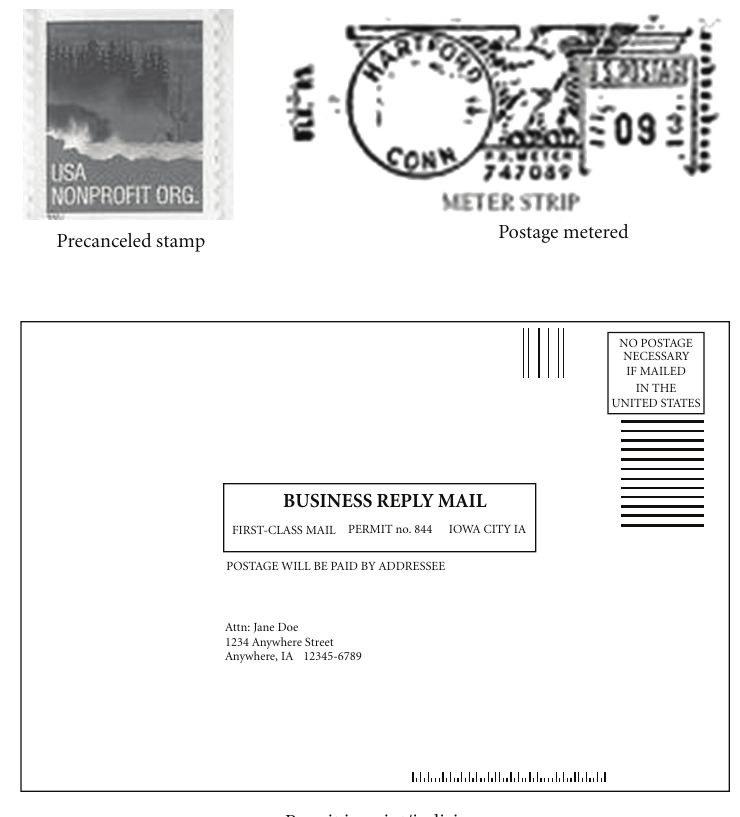
Figure 1: Depiction of precanceled stamp, postage metered, and permit